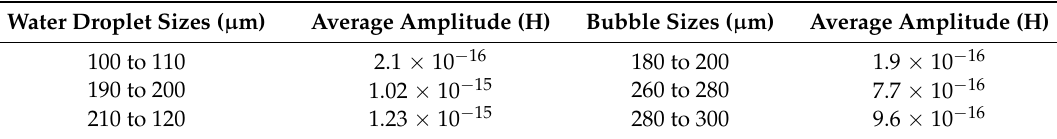
Table 3. The relationship between particle sizes and capacitance amplitudes, the excitation frequency is 0.3 MHz and the number of coil turns is 20